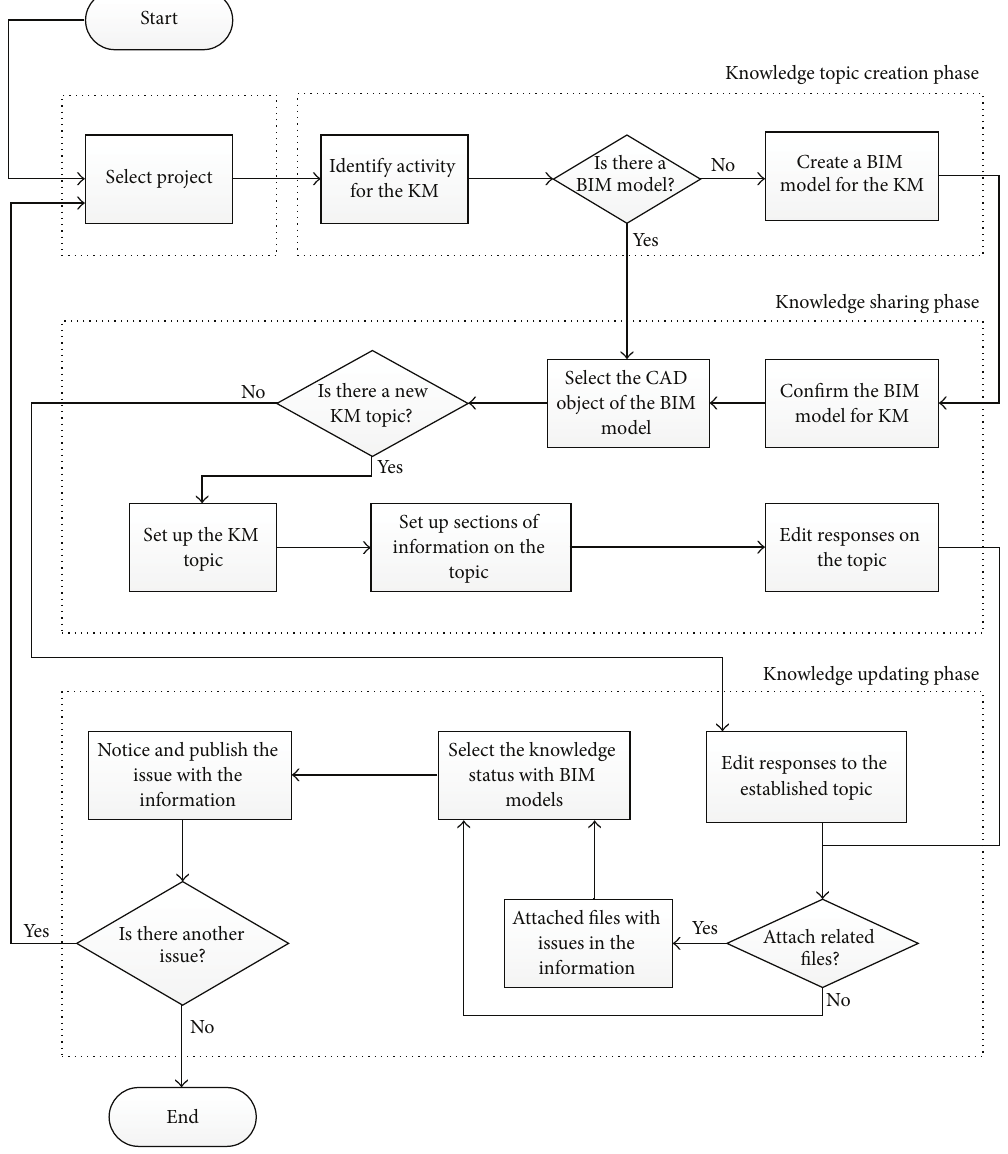
Figure 3: A flowchart of the procedure of the knowledge models